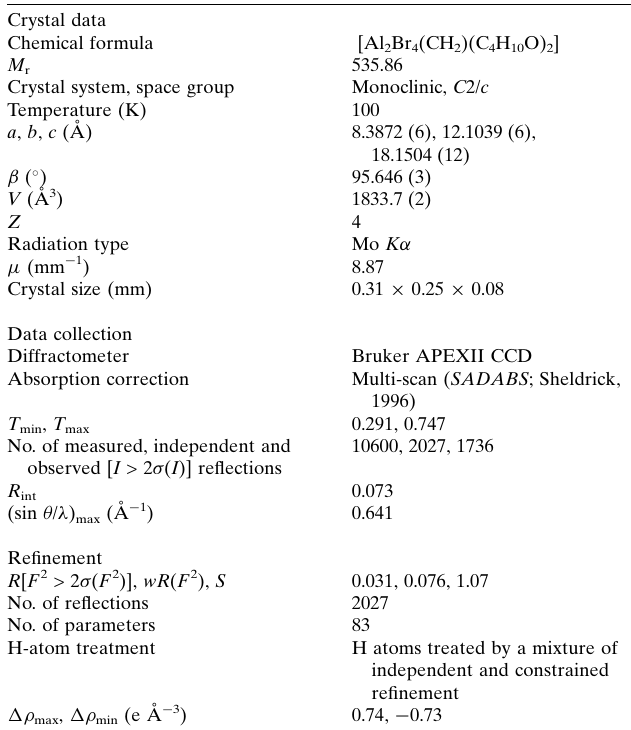
Crystal data Chemical